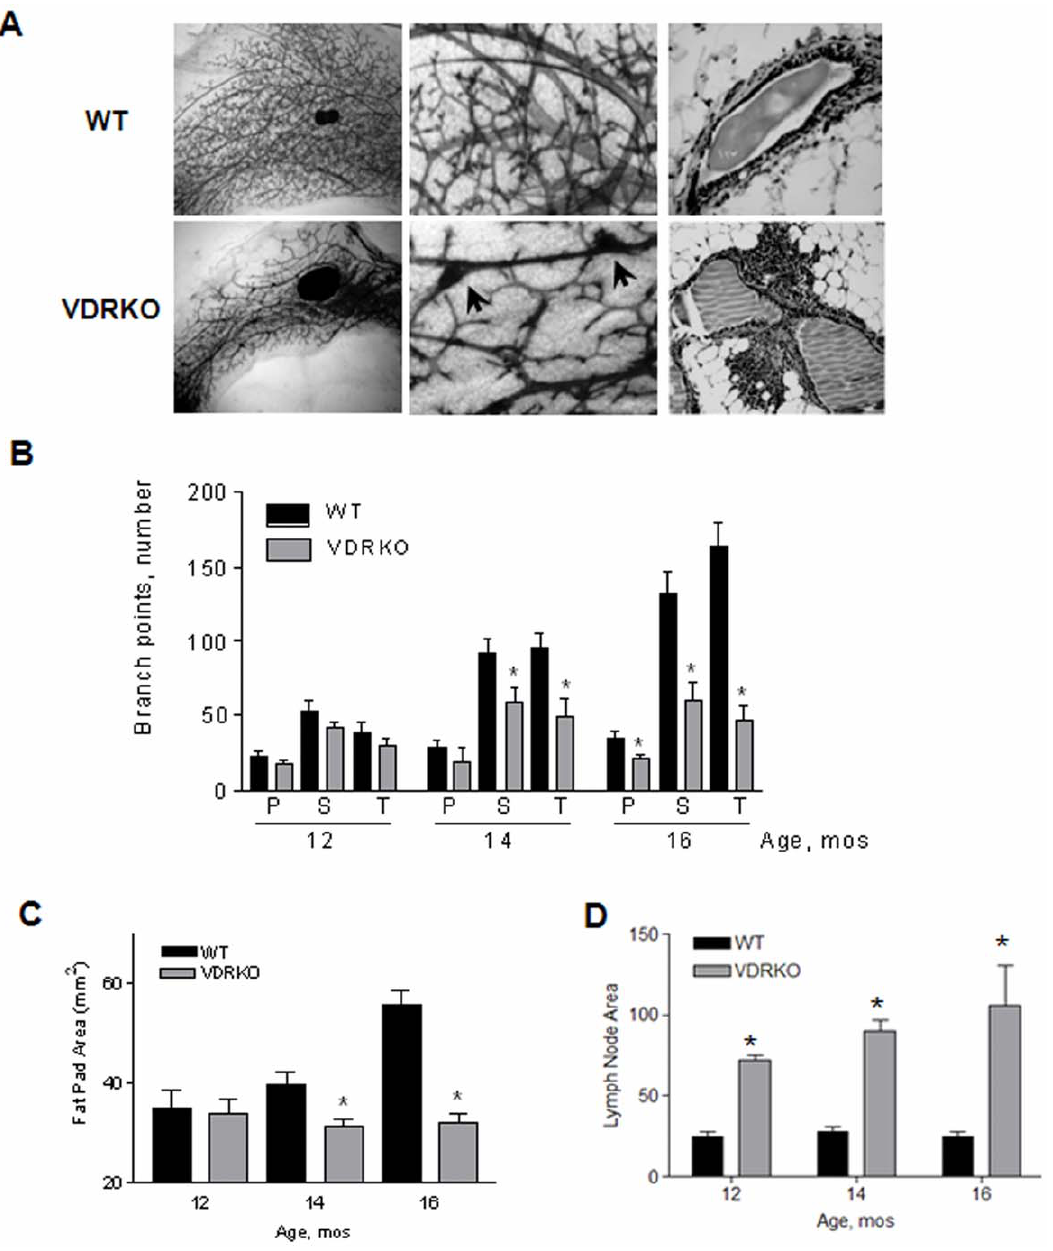
Figure 2. Morphological and quantitative assessment of inguinal mammary glands from 12, 14, and 16 month old WT and VDR KO mice. A. (Left Panels) Glands from VDR KO mice show decreased secondary and tertiary branching, signs of ductal thickening (ectasia), and large lymph nodes as the adipose tissue begins to atrophy with age. In contrast, WT glands show an extensive array of secondary and tertiary branches resting in a vast fat pad of plentiful adipose tissue. (Middle Panels) Glands at higher magnification from VDR KO mice show reduced secondary and tertiary branching and areas of darkly stained lesions along primary ducts (arrows). (Right Panels) Histological sections stained with hematoxylin and eosin Y show clusters of inflammatory cells along the primary ducts within glands of VDR KO mice compared to WT glands. B. Primary, secondary and tertiary branch points were quantitated as described in materials and methods. Primary branch counts showed a significant decrease between WT and KO glands at 16 months whereas secondary and tertiary branches were significantly decreased in glands from VDR KO mice at 14 and 16 months compared to WT control mice. *Statistically significant by Students t test, WT vs. VDR KO, n=10–12 p , 0.05. C. Whole mounts from VDR WT and KO mice were utilized to measure the area of mammary fat pads using AxioVision software. Fat pad area was calculated by tracing around the exterior of the ductal branches of the mammary fat pads. At 14 and 16 months of age, there is a significant reduction in the mammary fat pads of VDR KO mice compared to WT controls. *Statistically significant by Students t test, WT vs. VDR KO, n=10–12 p , 0.05. D. Whole mounts from VDR WT and KO mice were utilized to measure the mammary lymph nodes. Using AxioVision software, the exterior of the glandular lymph node was traced to calculate the area. At all time points, lymph nodes within glands from VDR KO mice were significantly enlarged compared to lymph nodes from WT mice. *Statistically significant by Students t test, WT vs. VDR KO, n=10–12 p , 0.05.